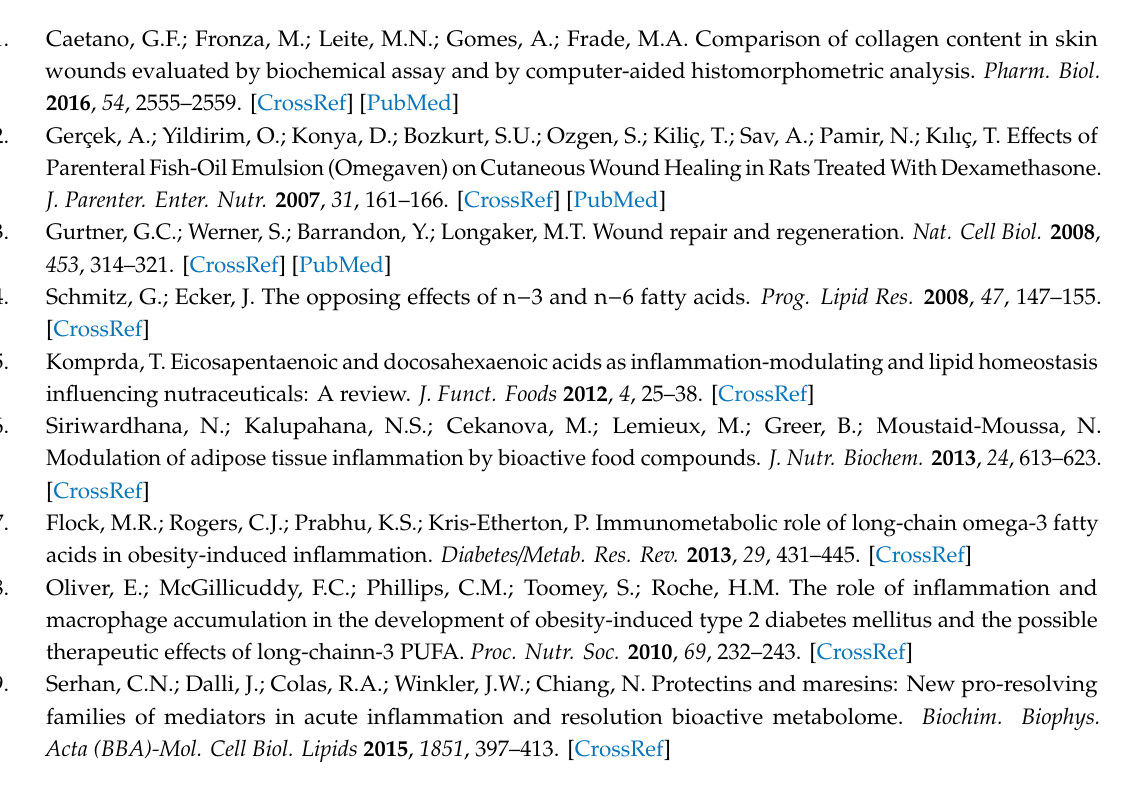
Figure S1: Fatty acid content in individual diets; Figure S2: Weight characteristics in experimental